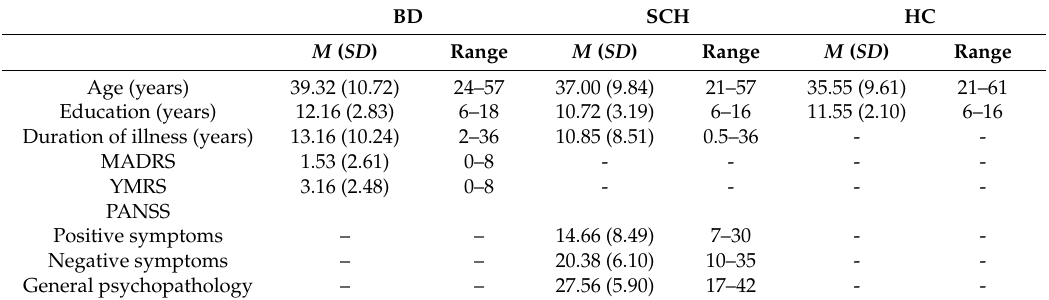
Table 1. Demographic characteristics of all participants and clinical characteristics of the patient